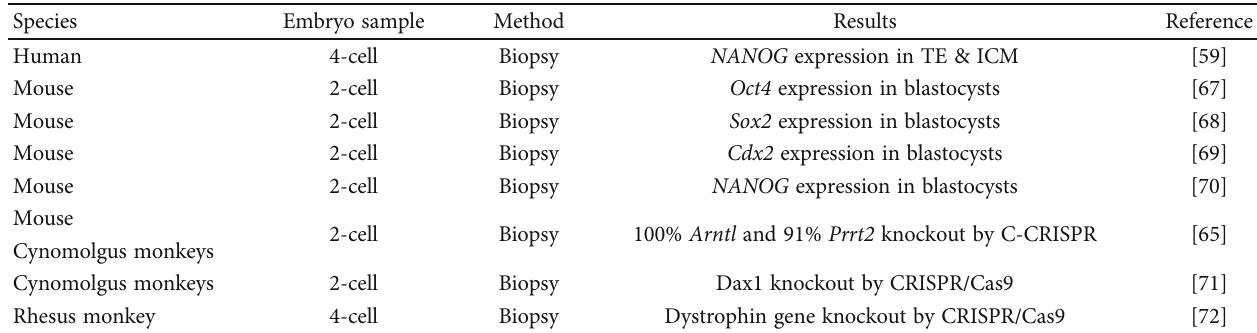
Table 5: Recent studies in embryo